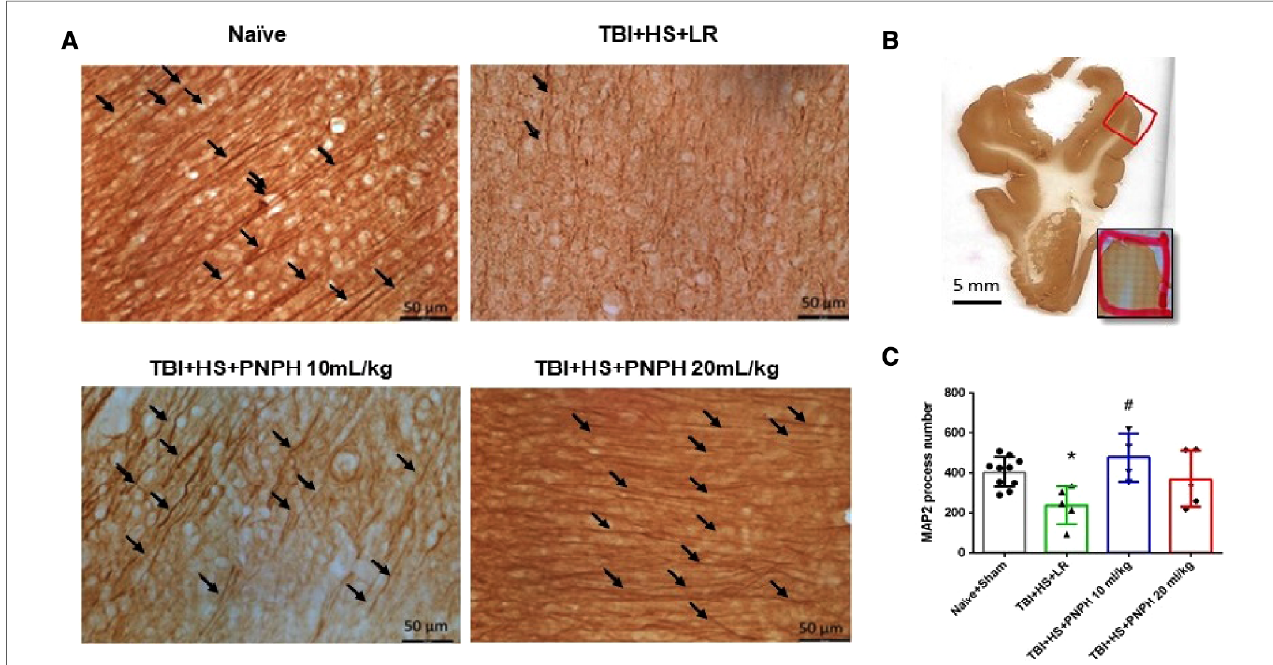
FIGURE 5 Effect of PNPH on MAP-2 – identi fi ed gray matter neuronal dendrites after TBI+hemorrhagic shock (HS). ( A ) Representative images of MAP-2 immunostaining from naïve pig and TBI pigs resuscitated with 60 ml/kg lactated Ringer ’ s (LR) solution or 10 ml/kg PNPH and 20 ml/kg PNPH. Arrows point to dendritic segments with >50 µm length from the gyrus of the cortex adjacent to the gyrus where the controlled cortical impact was produced. ( B ) The area used for MAP-2 analysis is outlined in the gyrus adjacent to the impacted gyrus. ( C ) The number of long dendrites in neocortex per coronal section averaged over 10 – 12 sections are plotted for the combined Naïve+Sham group ( n =10) and for TBI+HS groups resuscitated with 60 ml/kg LR ( n =5), 10 ml/kg PNPH ( n =4), and 20 ml/kg PNPH ( n =5). The dose of 10 ml/kg of PNPH blocked the decrease in long dendrites seen in the LR group. Mean±SD and individual data for each pig are shown. * P <0.05 vs. combined Naïve+Sham group, # P <0.05 vs. TBI+HS+LR group determined by one-way ANOVA and the Holm-Sidak procedure for multiple